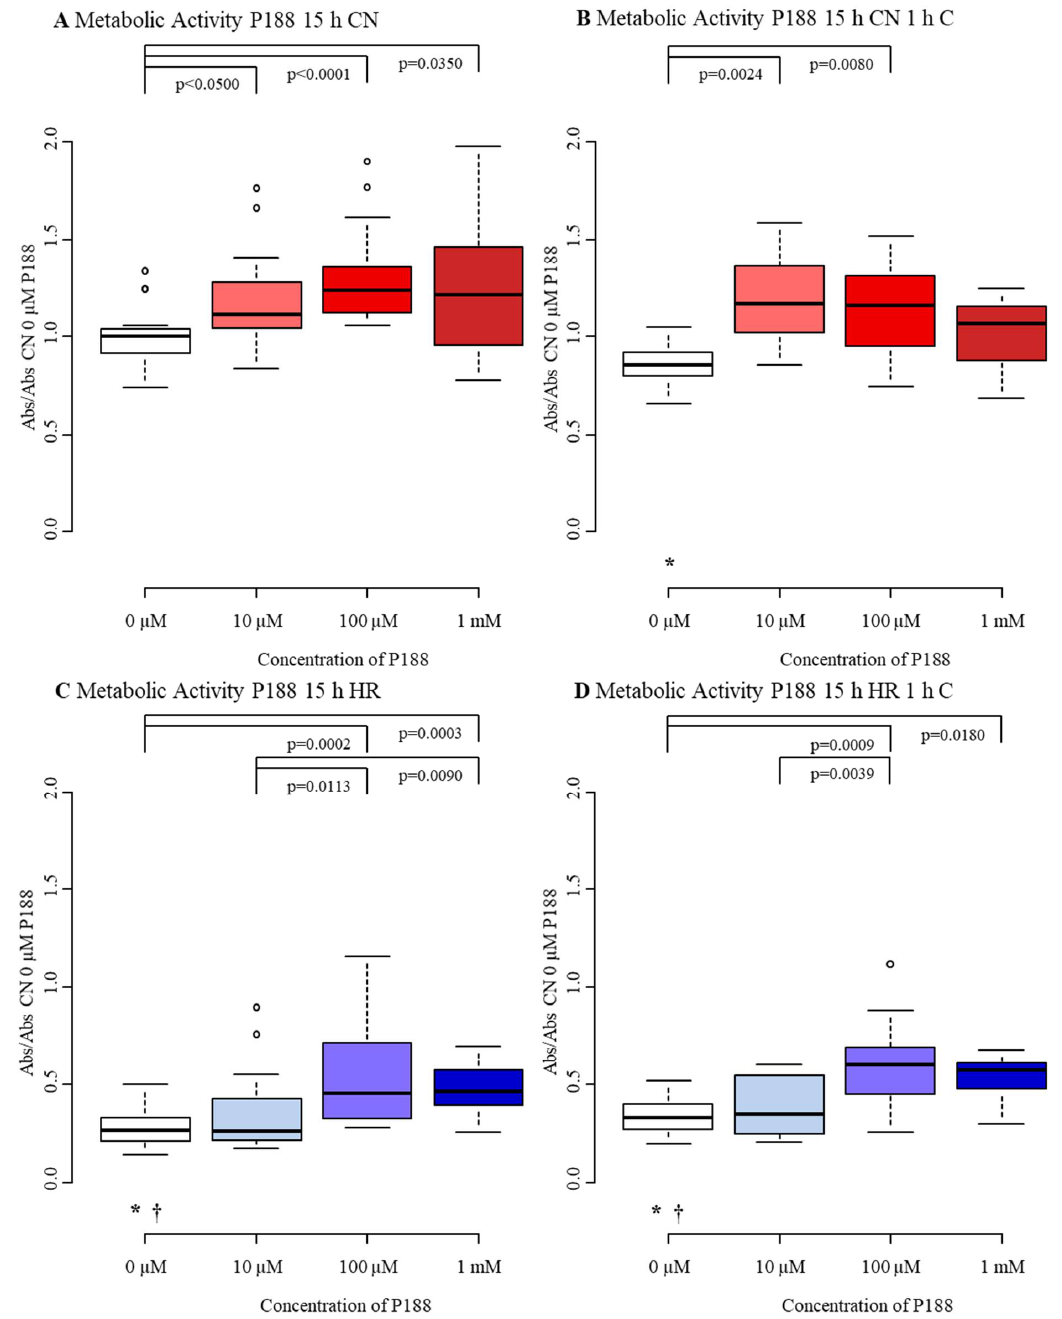
Figure A3. Metabolic activity after 15 h injury and treatment with 0 µ M, 10 µ M, 100 µ M, and 1 mM of P188. ( A ) normoxia (CN-C); ( B ) normoxia and 1 h compression (CN+C); ( C ) hypoxia (HR-C); ( D ) hypoxia and 1 h compression (HR+C). Data visualized as boxplots (median, 25th, 75th percentile, whiskers: minimum, maximum, dots: potential outliers); p < 0.05; n = 4 experiments/group. Significances between different concentrations of P188 are displayed as brackets, significances between ( A – D ) for 0 µ M P188 are represented by symbols (* vs. CN-C 0 µ M P188, † vs. CN+C 0 µ M P188). Abbreviations: Abs, absorbance; C, compression; CN, control/normoxia; h, hours; HR, hypoxia/reoxygenation; mM, millimolar; µ M, micromolar; P188, Poloxamer 188. Colors: red, normoxia; blue, hypoxia/reoxygenation. The shadows of red/blue represent the different concentrations of